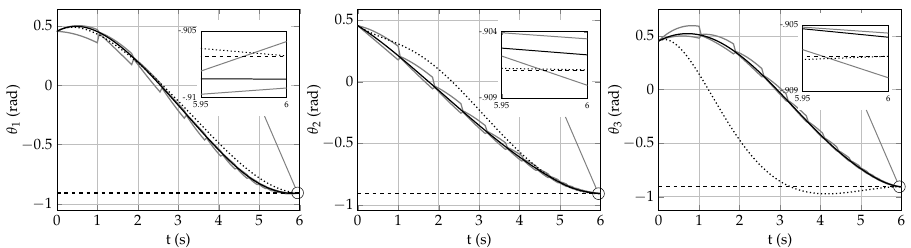
Figure 8. Attitude of the spacecraft. The black curves are the attitude of the actual nonlinear system, whereas the gray curves are the attitudes of the auxiliary linear systems. The dashed line is the desired final attitude and the dotted line a solution using a non-convex solver.